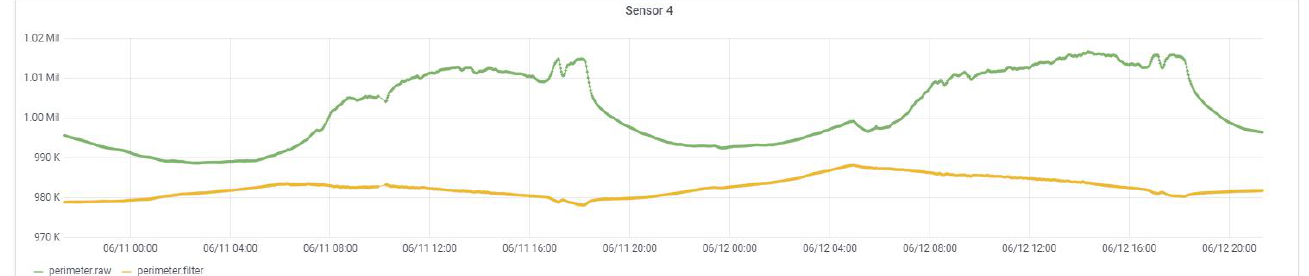
Figure 7. CEMF compensated